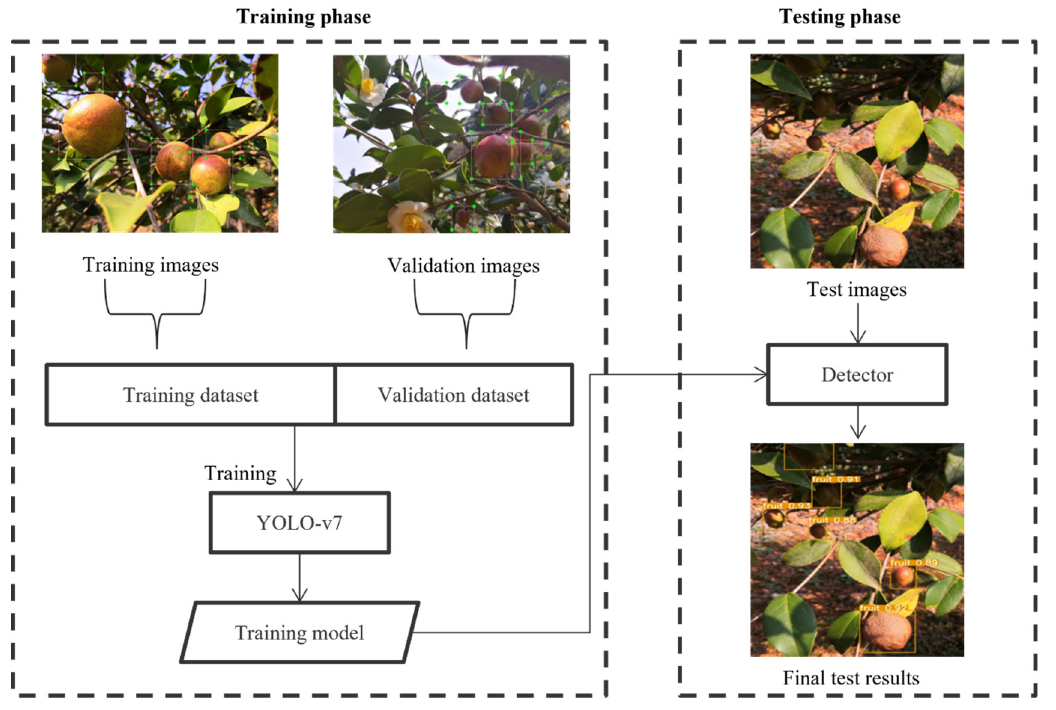
Figure 6. Workflow of the proposed study.